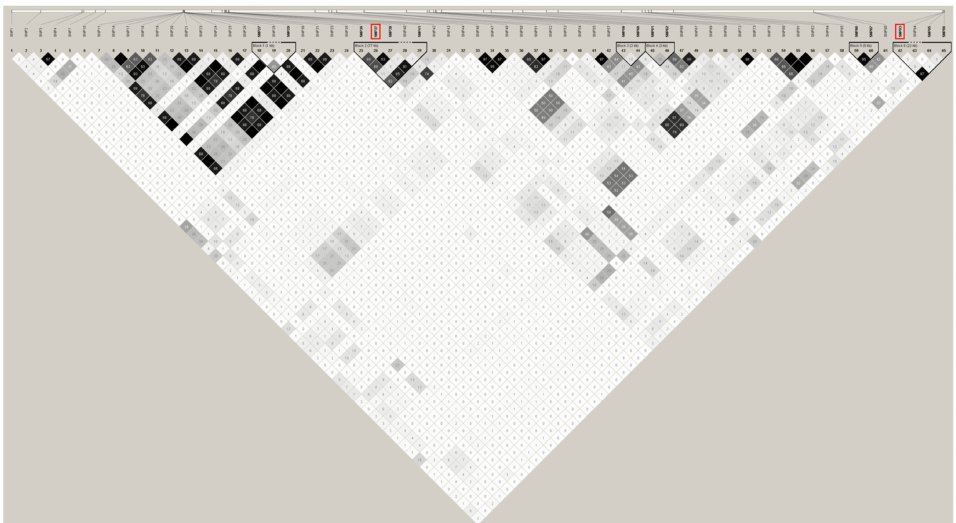
Figure 2. SNPs’ significance plot for BMS and LD block from 10 to 30 Mbp on BTA7 in Miyazaki population. The x -axis indicates chromosome 7 positions in base pairs, and the y -axis indicates log– inverse p -values. Significance of SNPs is represented as blue circle for independent SNP associations and as yellow triangle for SNP associations estimated by fitting SNP37_ ICAM1 SNP as a fixed effect in the model. The significance of SNP93_ ALDH7A1 and SNP37_ ICAM1 SNP is represented by red circle. The dashed green line indicates the threshold of the 5% significance level. LD coefficients ( r 2 ) between the SNPs in this region. Black squares indicate r 2 values >0.80, and white and gray indicate r 2 values <0.80. SNP93_ ALDH7A1 and SNP37_ ICAM1 SNP are shown by a red frame.